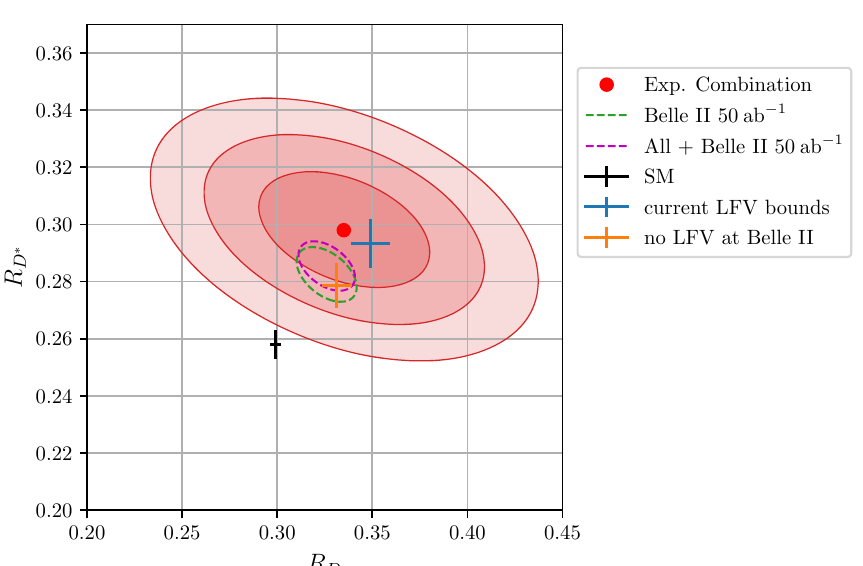
Fig. 7 Likelihood contours and vector leptoquark predictions for R D and R D ∗ . Red regions correspond to different likelihood contours obtained from a naïve combination of the experimental likelihoods. The blue cross denotes the predictions at the best-fit point to current LFV data. The orange cross denotes the predictions at the best-fit point with assumed null results of LFV processes at Belle II, Mu2e and COMET.